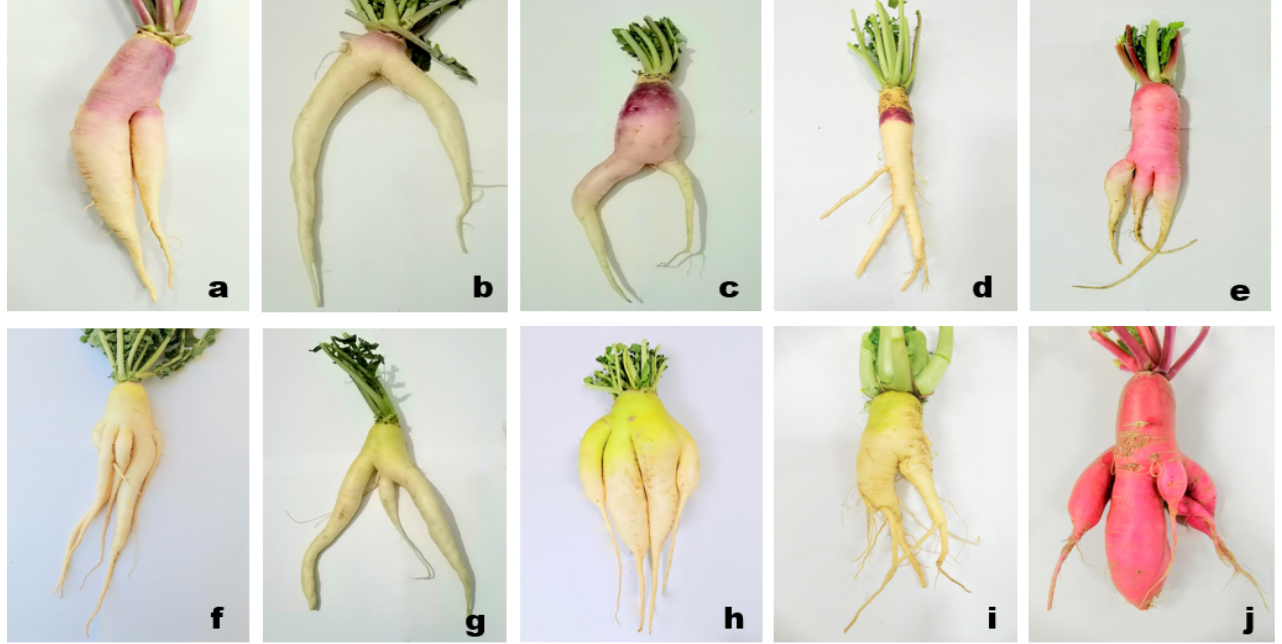
Figure 2. Different type of forking disorder in various radish cultivars: ( a – e ) (Purple neck), ( f – i ) (Green neck), ( j ) (Bari